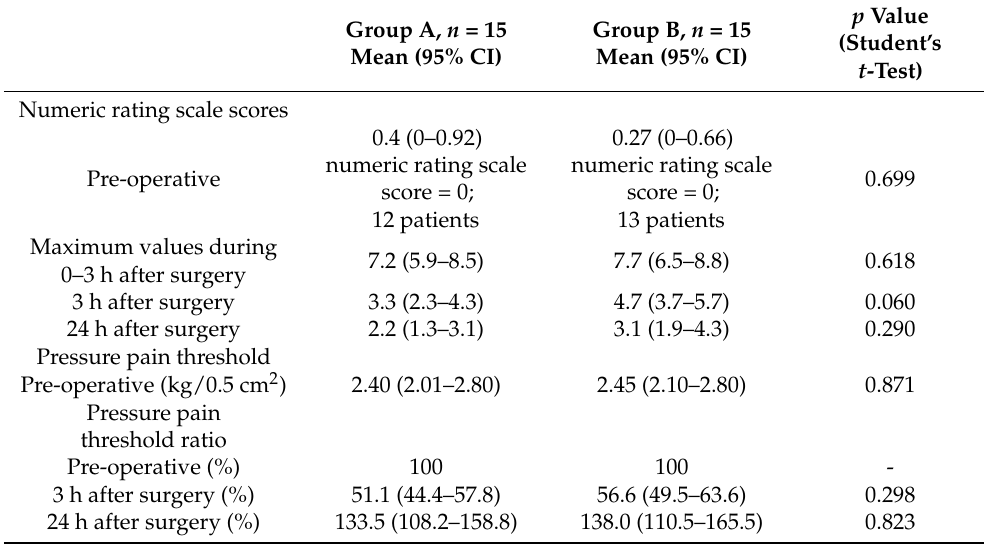
Table 3. Evaluation of numeric rating scale scores and pressure pain